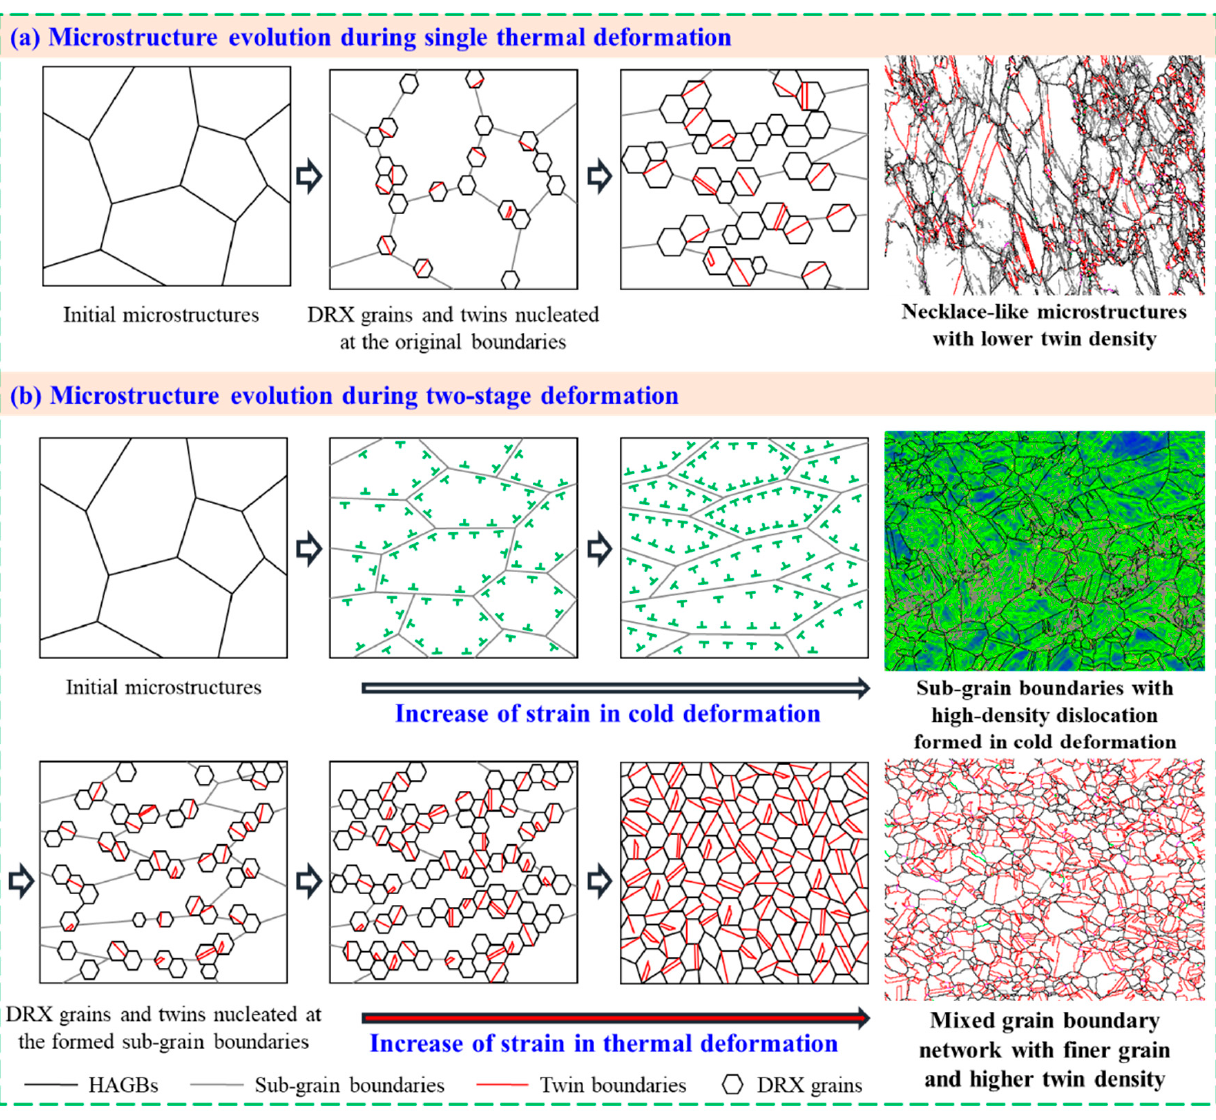
Figure 13. Schematic representation of microstructure evolution during single thermal deformation and two-stage deformation.